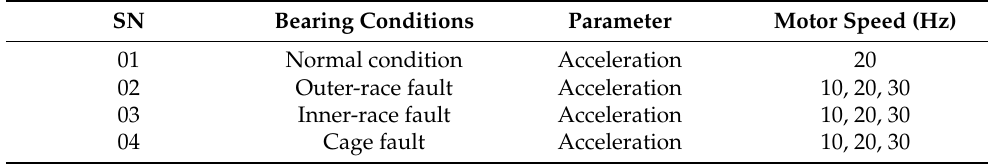
Table 1. Data generation